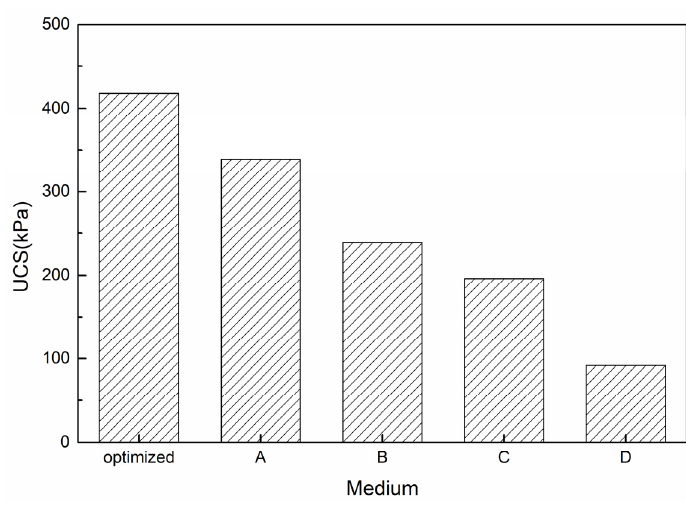
Figure 5. UCS values for solidified columns.